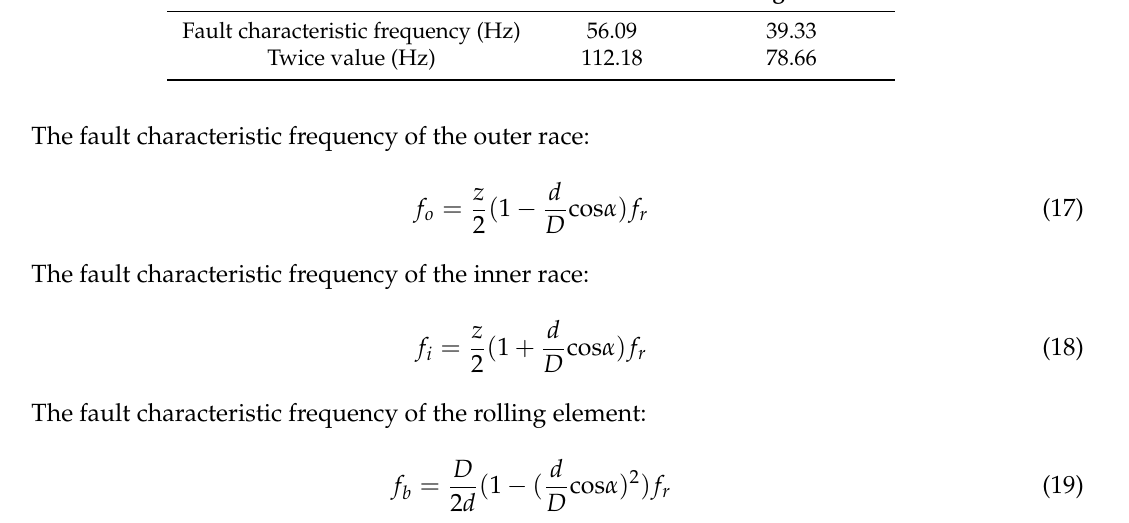
Table 1. Fault characteristic frequency